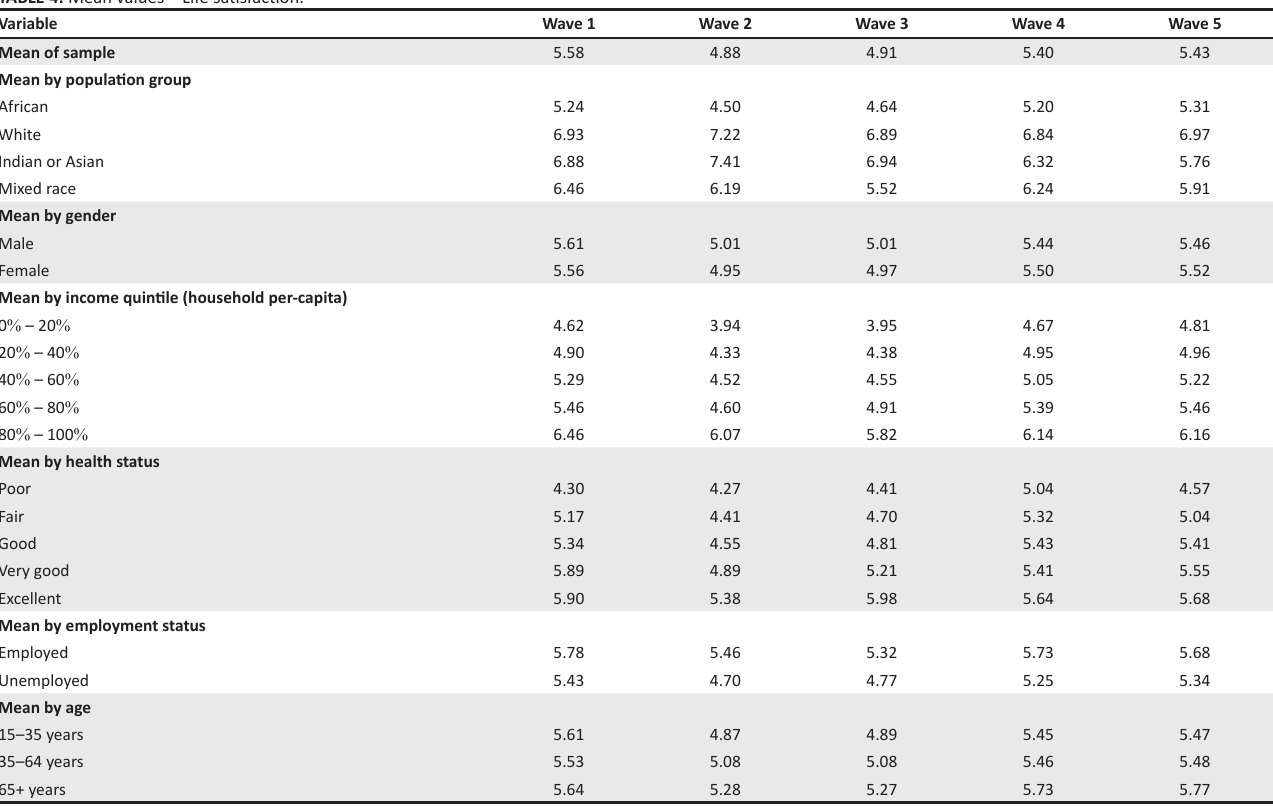
TABLE 4: Mean values – Life satisfaction.